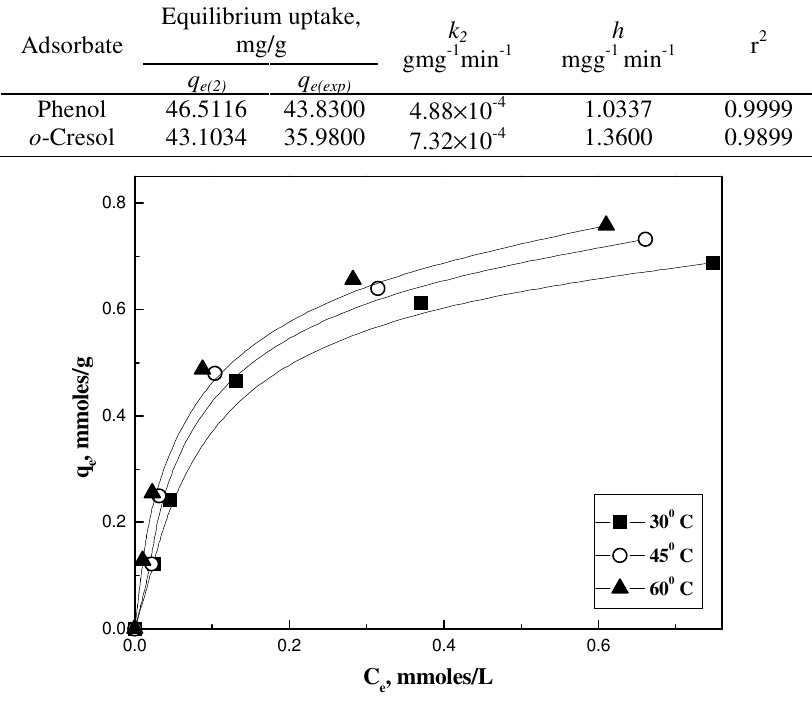
Figure 4. Adsorption of phenol on CC: Effect of